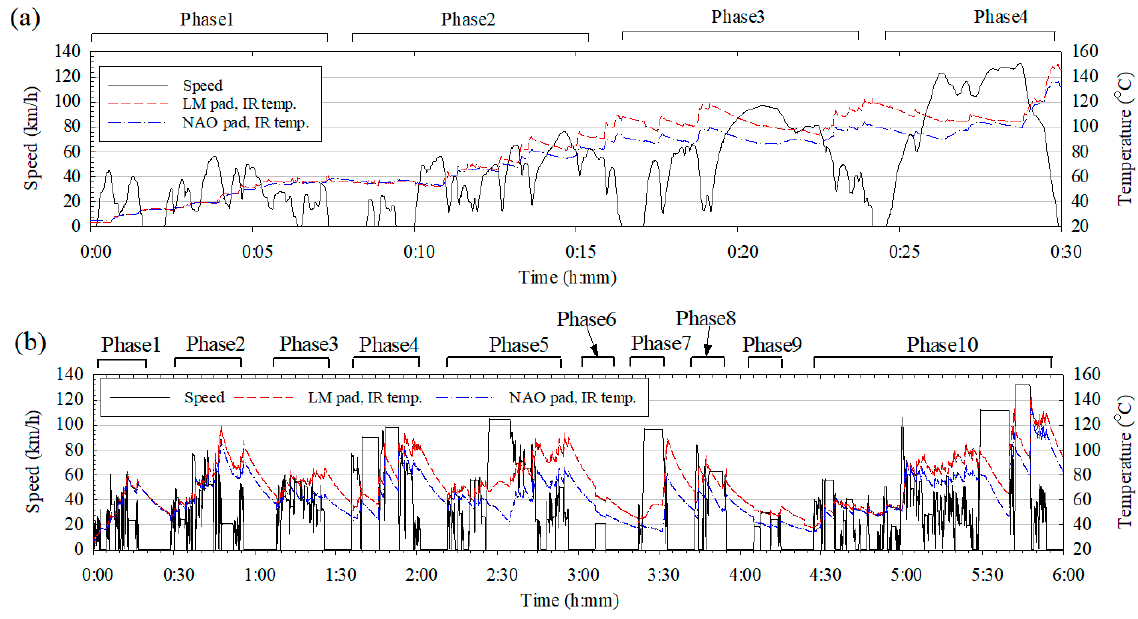
Figure 3. Speed–time schedule of ( a ) the WLTC and ( b ) the